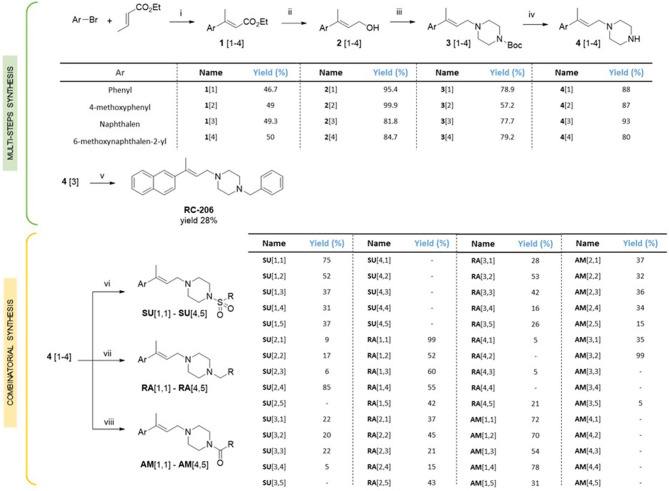
Synthesis of the compound library. Reagents and reaction conditions: (i) Pd EnCat (0.01 equiv.), TEAC (2 equiv.), AcONa (2 equiv.), dry DMF, 105 °C; (ii) LiAlH4 (1M in THF, 1 equiv.), dry Et2O, 0°C; (iii) PPh3 (1.5 equiv.), NBS (1.4 equiv.), 1-Boc-piperazine (1.2 equiv.), Et3N (2 equiv.), THF, −18°C; (iv) HCl 4 N, 1,4-dioxane, 0°C to RT; (v) benzaldehyde (1 equiv.), AcOH (2 equiv.), DCE (2 equiv.), RT, 20 min, then NaBH(OAc)3 (2.5 equiv.), RT, o.n.; (vi) RSO2Cl (1.5 equiv.), TEA (5 equiv.), DCM, RT, o.n.; (vii) RCHO (1 equiv.), AcOH (2 equiv.), DCE (2 equiv.), RT, 20 min, then NaBH(OAc)3 (2.5 equiv.), RT, o.n.; (viii) RCO2H (2 equiv.), DIPEA (5 equiv.), HOBt (2 equiv.), EDC·HCl (2.5 equiv.), DMF, RT, o.n.